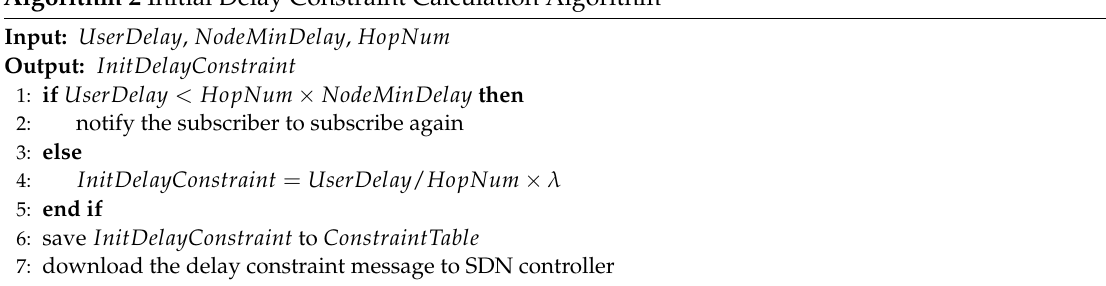
Algorithm 2 Initial Delay Constraint Calculation Algorithm